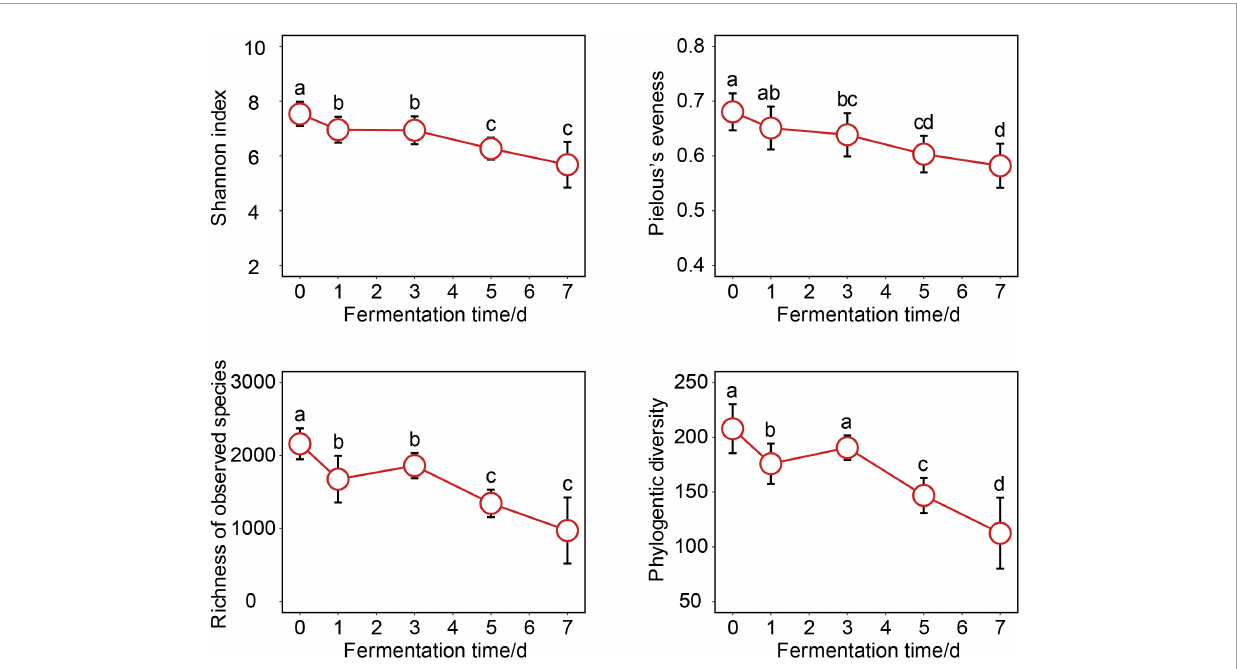
FIGURE1 Changes of bacterial α -diversity indices over crab paste fermentation. Data present means ± standard deviation. Different letters indicate significant differences among groups ( p < 0.05).